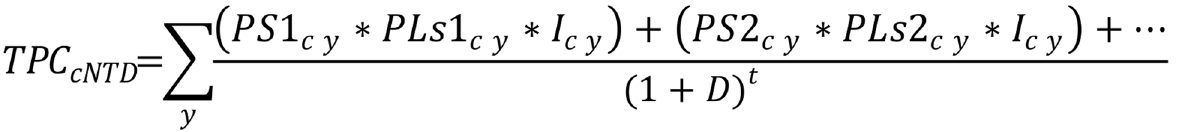
Fig 1. General formula for calculating productivity loss. TPC = Total productivity costs (in US$ 2005), NTD = Neglected Tropical Disease, c = Country, y = Year, PS1 = Number of prevalent cases aged 15+ years with sequela 1, PS2 = Number of prevalent cases aged 15+ years with sequela 2, PLs1 = % productivity loss related to sequela 1 of NTD, PLs2 = % productivity loss related to sequela 2 of NTD, I = GDP per capita in the lowest quintile, D = Annual discount rate, t = Time (years beyond